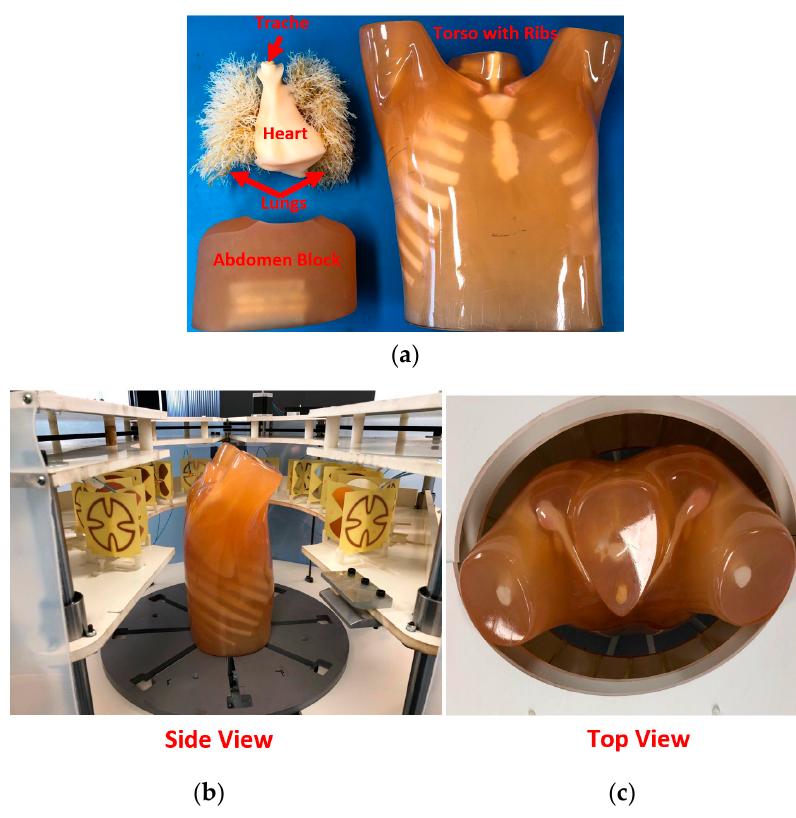
Figure 6. ( a ) Utilized torso phantom, and positioning of the phantom inside the scanner: ( b ) side view and ( c ) top view.